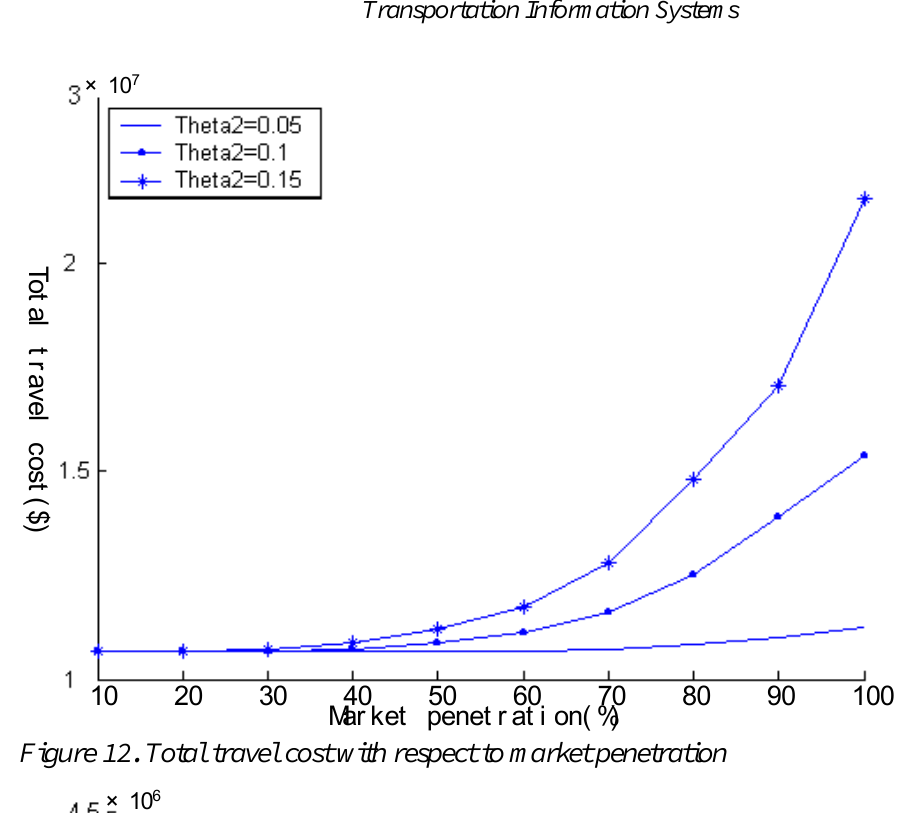
Figure 12. Total travel cost with respect to market penetration